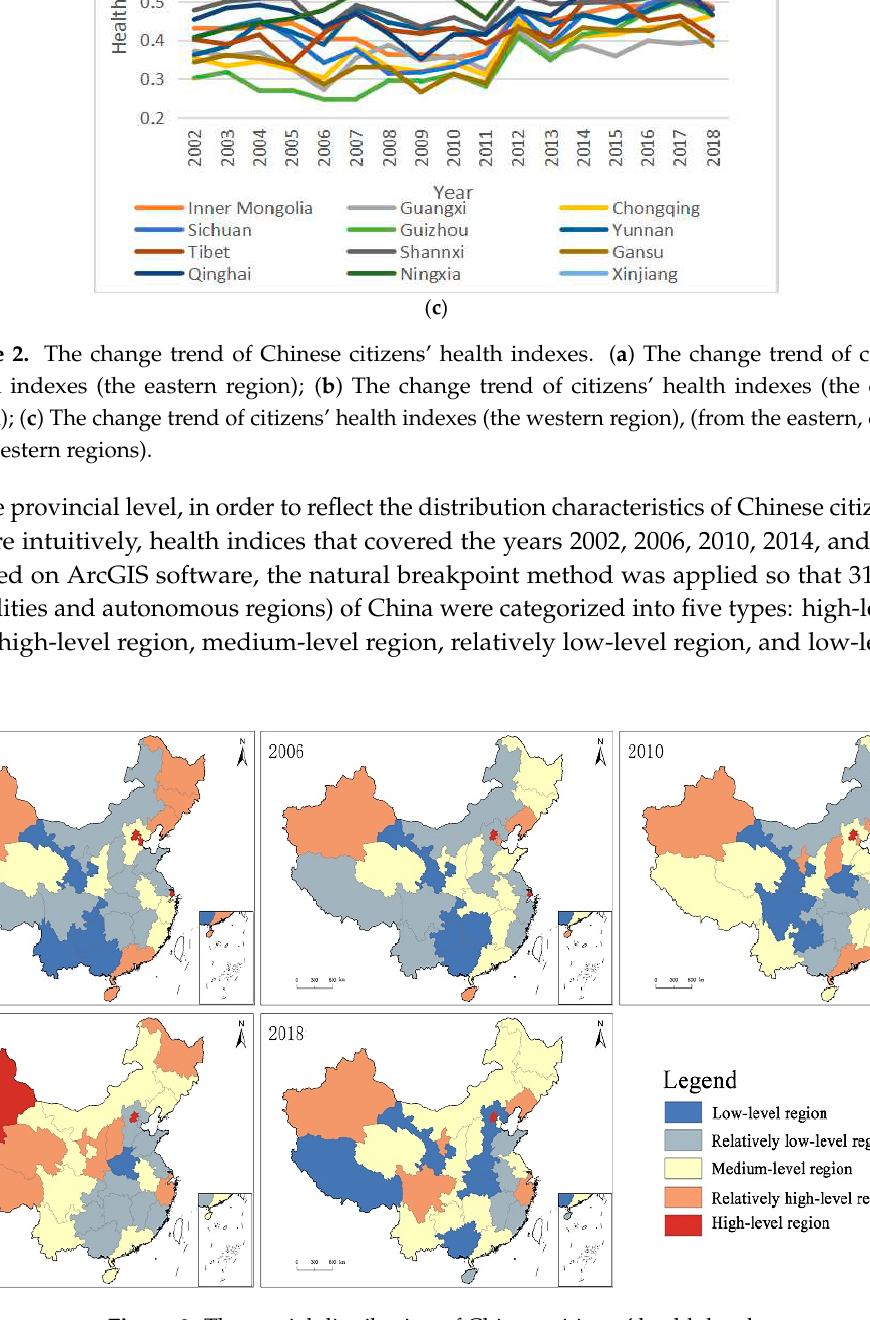
Figure 3. The spatial distribution of Chinese citizens’ health levels.